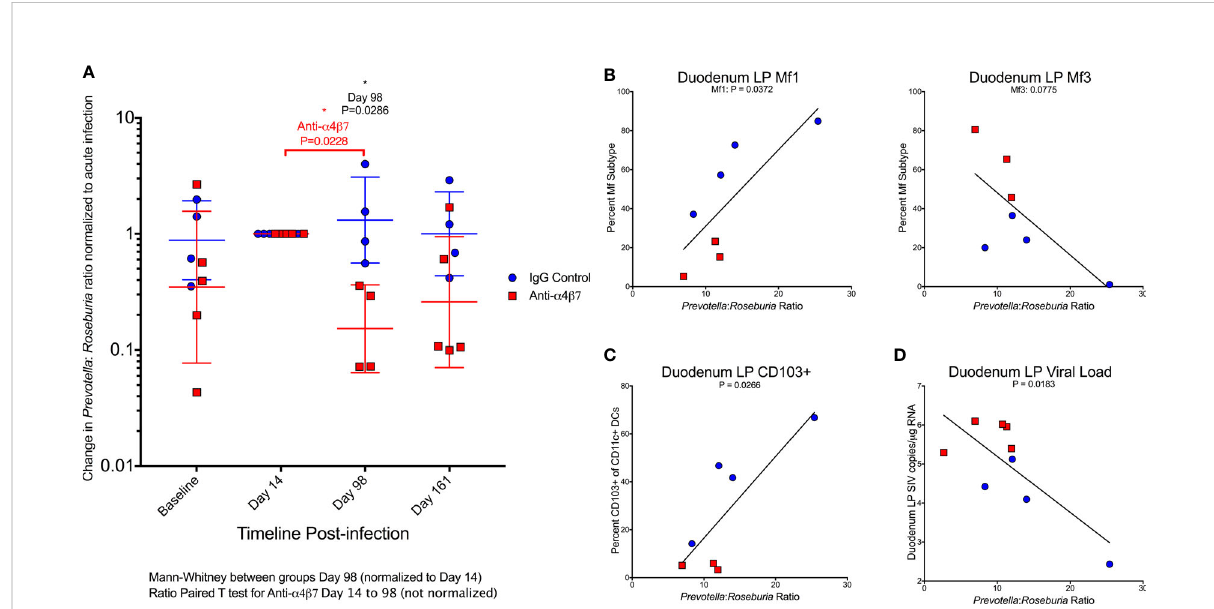
FIGURE 5 Anti- a 4 b 7 therapy is associated with a reduction in the Prevotella : Roseburia ratio. (A) The ratio of Prevotella : Roseburia was calculated and normalized (for visualization and comparison) for the acute infection dysbiosis timepoint (Day 14) for longitudinal fecal samples utilized for 16S rRNA sequencing. Linear regression was performed with this ratio (not normalized) on Day 161 for (B) the duodenal lamina propria macrophage maturity phenotypes, (C) CD103+ CD11c+ cells, and (D) tissue viral